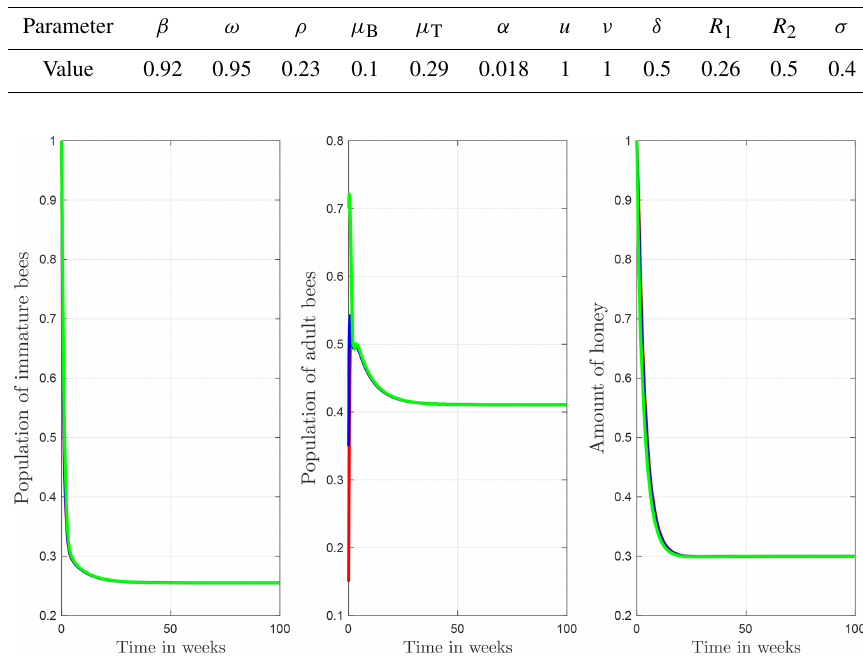
Table 5. Parameter values used for numerical simulations in Figs. 7 and 8.